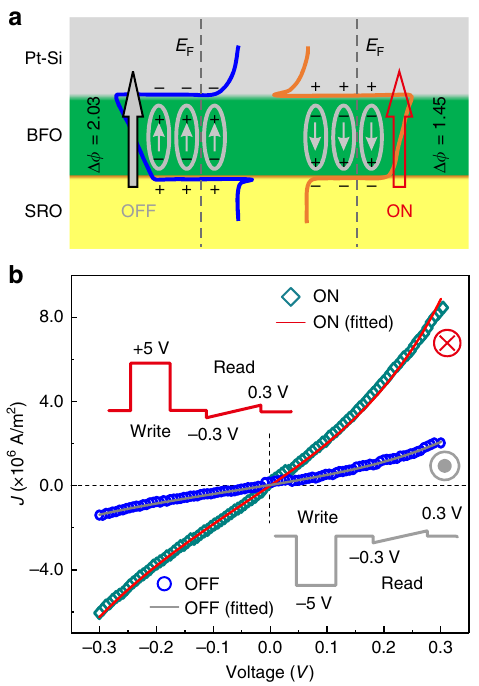
Fig. 4 Ferroelectric tunneling junction and tunneling mechanism in 1-u.c. BFO. a Schematic of electrostatic potential ( ϕ ) pro fi les in the OFF and ON states. The Fermi level is marked by the gray dashed lines. The small arrows represent the ferroelectric polarization vector. The large solid (gray) and open (red) arrows indicate the magnitude of tunneling current. b J – V curves in the small range of voltage for two opposite polarization orientation (blue, down, orange, up). Solid lines show fi tting of experimental data using direct tunneling mechanism based on the WKB theory. The inset in ( b ) illustrates the write and read voltage sequences for J – V measurements